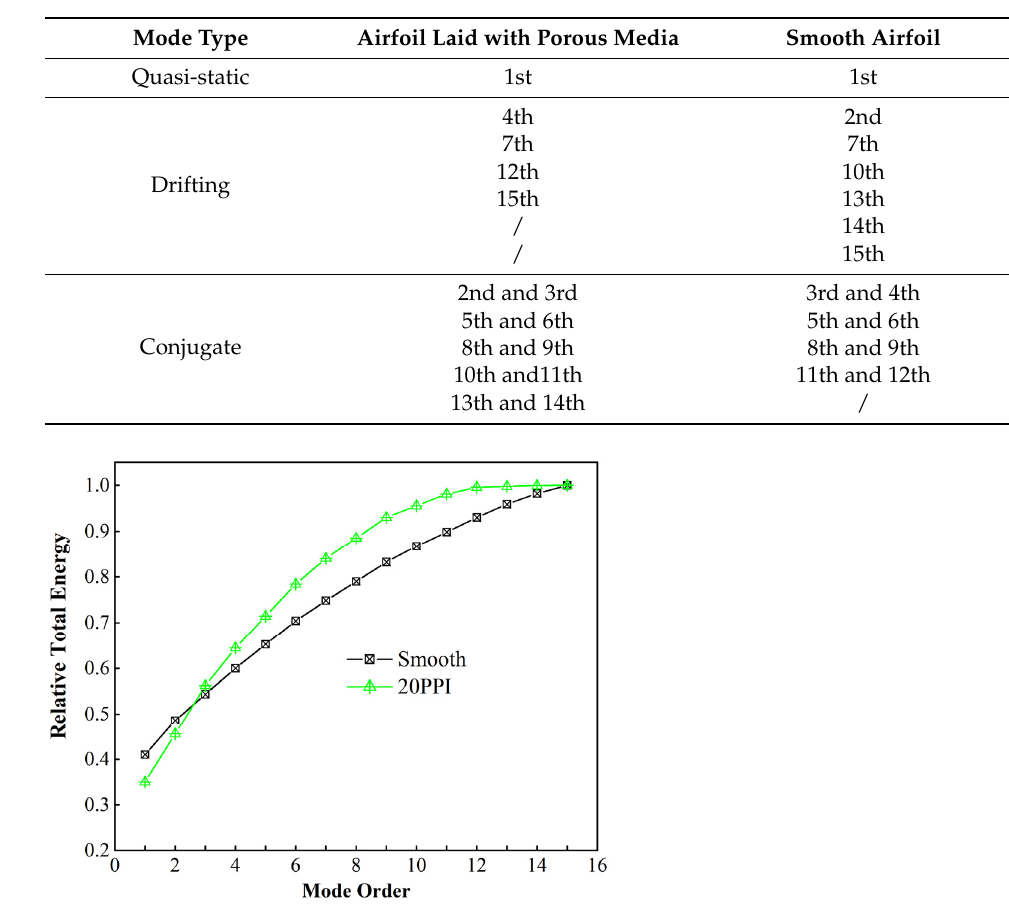
Table 2. First 15 DMD mode classification.